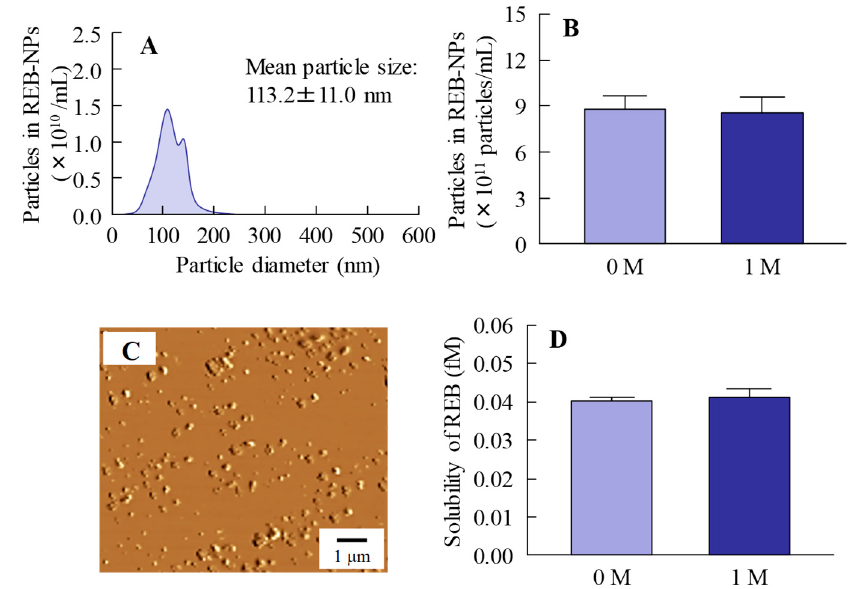
Figure 2. Stability of rebamipide solid in REB-NPs one month after preparation. ( A ) REB-NPs size by dynamic light scattering measurement. ( B ) Number of rebamipide nanoparticles in REB-NPs. ( C ) AFM image of REB-NPs. (D) Drug solubility in REB-MPs and REB-NPs. n = 6. * P < 0.05, vs. REB-MPs. The rebamipide solid in REB-NPs remained in the nano-size range, and no difference was observed in either the shape or solubility after one month.